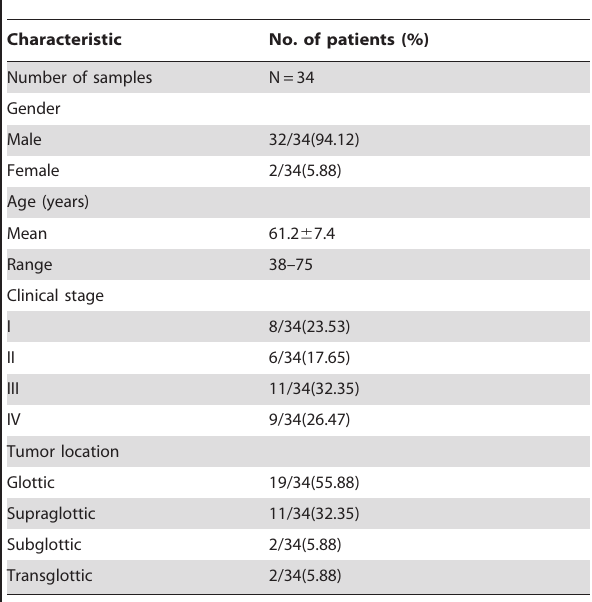
Table 1. Clinical characteristics of the patients